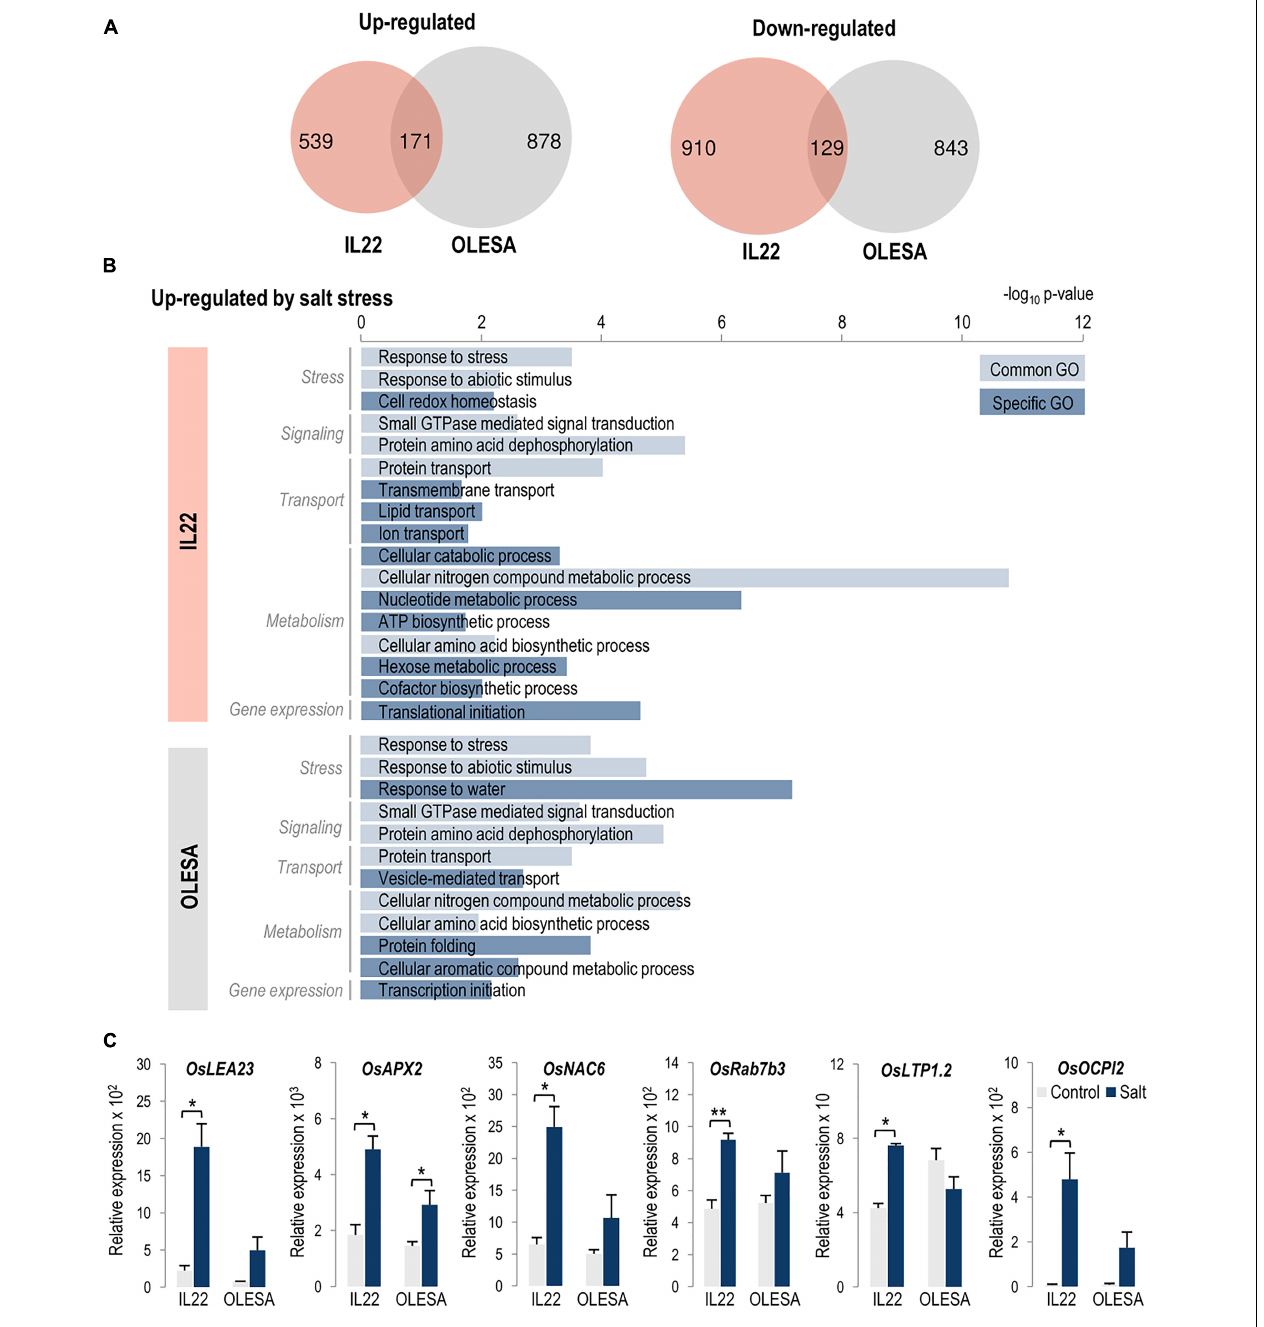
FIGURE 7 | Comparison of OLESA and IL22 transcriptomes in response to salt stress (80 mM NaCl, 24 h of treatment). (A) Venn diagrams indicate the number of genes that are specifically and commonly regulated by salt stress in each genotype, up-regulated and down-regulated genes (log 2 fold change > 0.5 or < –0.5; P -value ≤ 0.05). (B) Enriched GO terms in biological processes in the up-regulated genes in each genotype performed using AgriGO (Tian et al., 2017). Light and dark blue bars indicate common and genotype-specific GO terms, respectively. The scale shows the statistical significance (–log 10 P -value). (C) Salt-responsiveness of genes identified in japonica regions of IL22 and OLESA. Plants were grown in hydroponic cultures under control and salt-conditions (24 h of salt treatment, 80 mM NaCl). Transcript levels of the indicated genes were determined by RT-qPCR. OsUbi1 was used as the reference gene. Bars represent means of three biological replicates, each one from a pool of four different plants, ± SEM (Student’s t -test, * P ≤ 0.05, ** P ≤ 0.005). OsLEA23 ( Late Embryogenesis Abundant protein 23 ), OsAPX2 ( Ascorbate peroxidase 2 ), OsNAC6 ( NAM/ATAF/CUC 6 TF), OsRab7b3 ( Ras-related in brain 7 B3 ); OsLTP1.2 ( Lipid transfer protein 1.2 ), and OsOCPI2 ( Oryza sativa chymotrypsin inhibitor-like 2 ). Primers and locus ID are listed in Supplementary Table 2 .